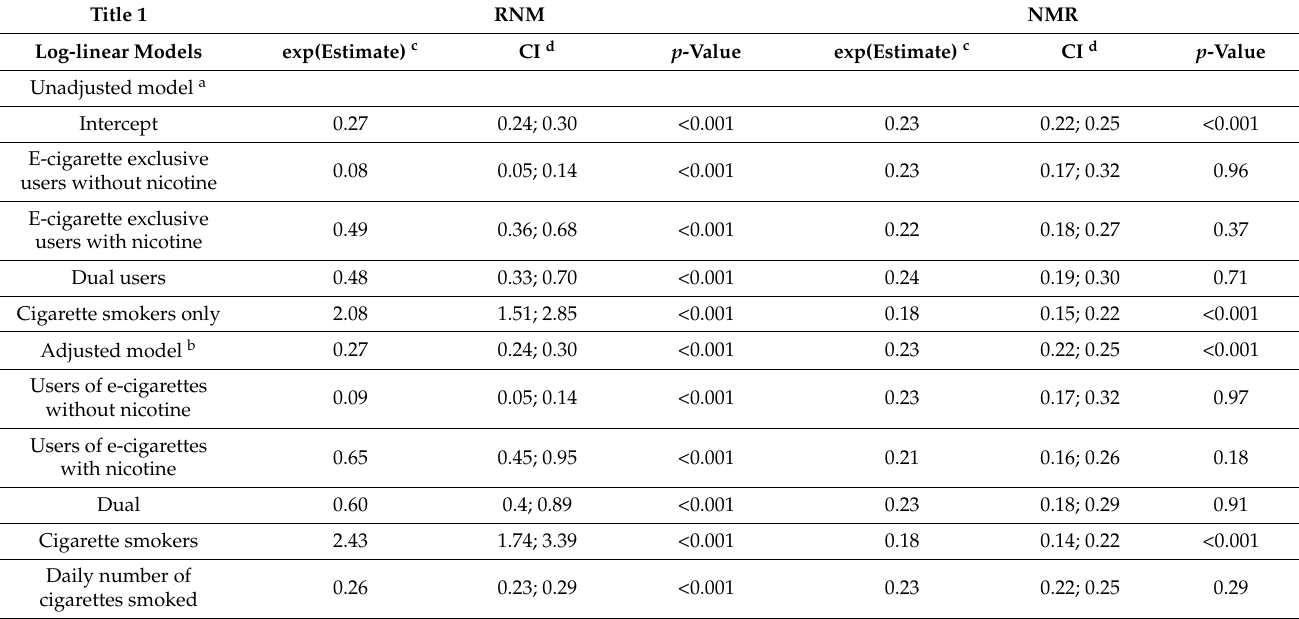
Table 2. Log-linear models for Smoking and e-cigarette status (nonusers as reference) for Rate of Nicotine Metabolism (RNM) and Nicotine Metabolite Ratio (NMR). The first one (Unadjusted Model) and the second one with its presence (Adjusted